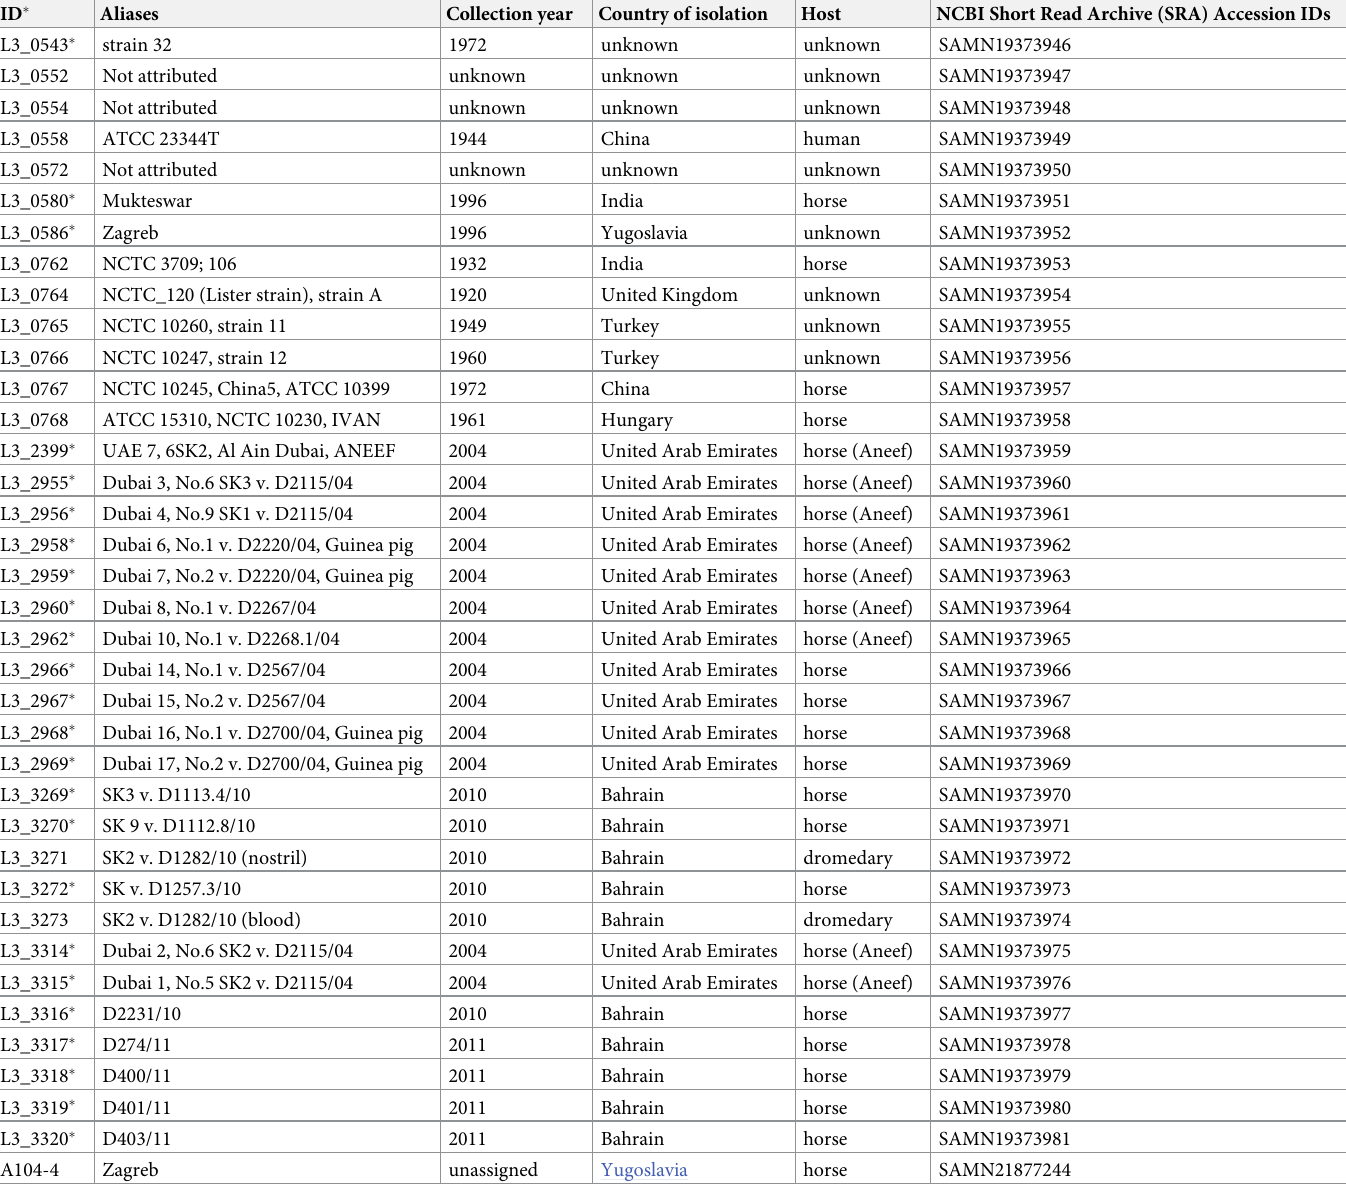
Table 1. Information on the sequenced B . mallei genomes included in this